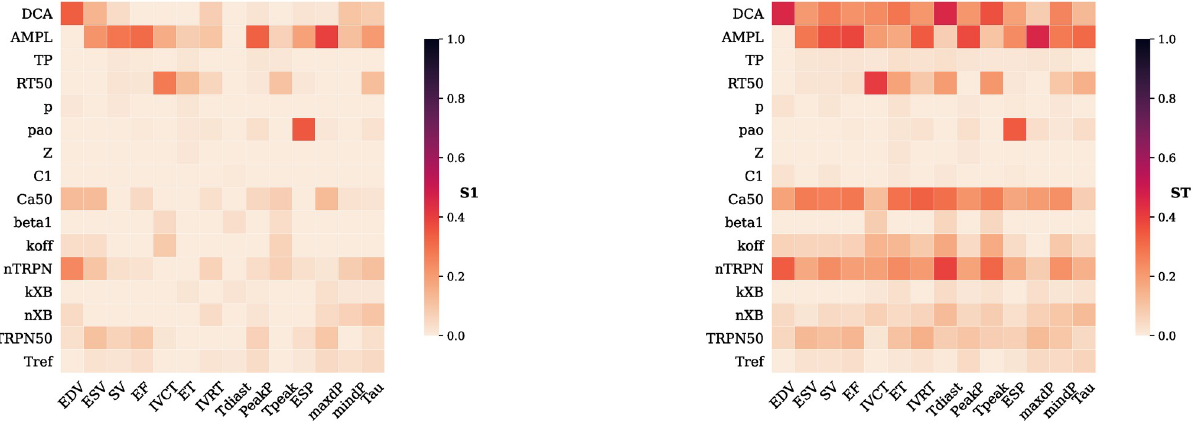
Fig 3. Sobol’ first-order (S1) and total effects (ST). The contribution of each parameter (Table 1) by itself (S1) or jointly with the other parameters (ST) into explaining the total variance of each LV feature (Table 2) is expressed as Sobol’ indices ranging from 0 (no effect) to 1 (maximal effect).